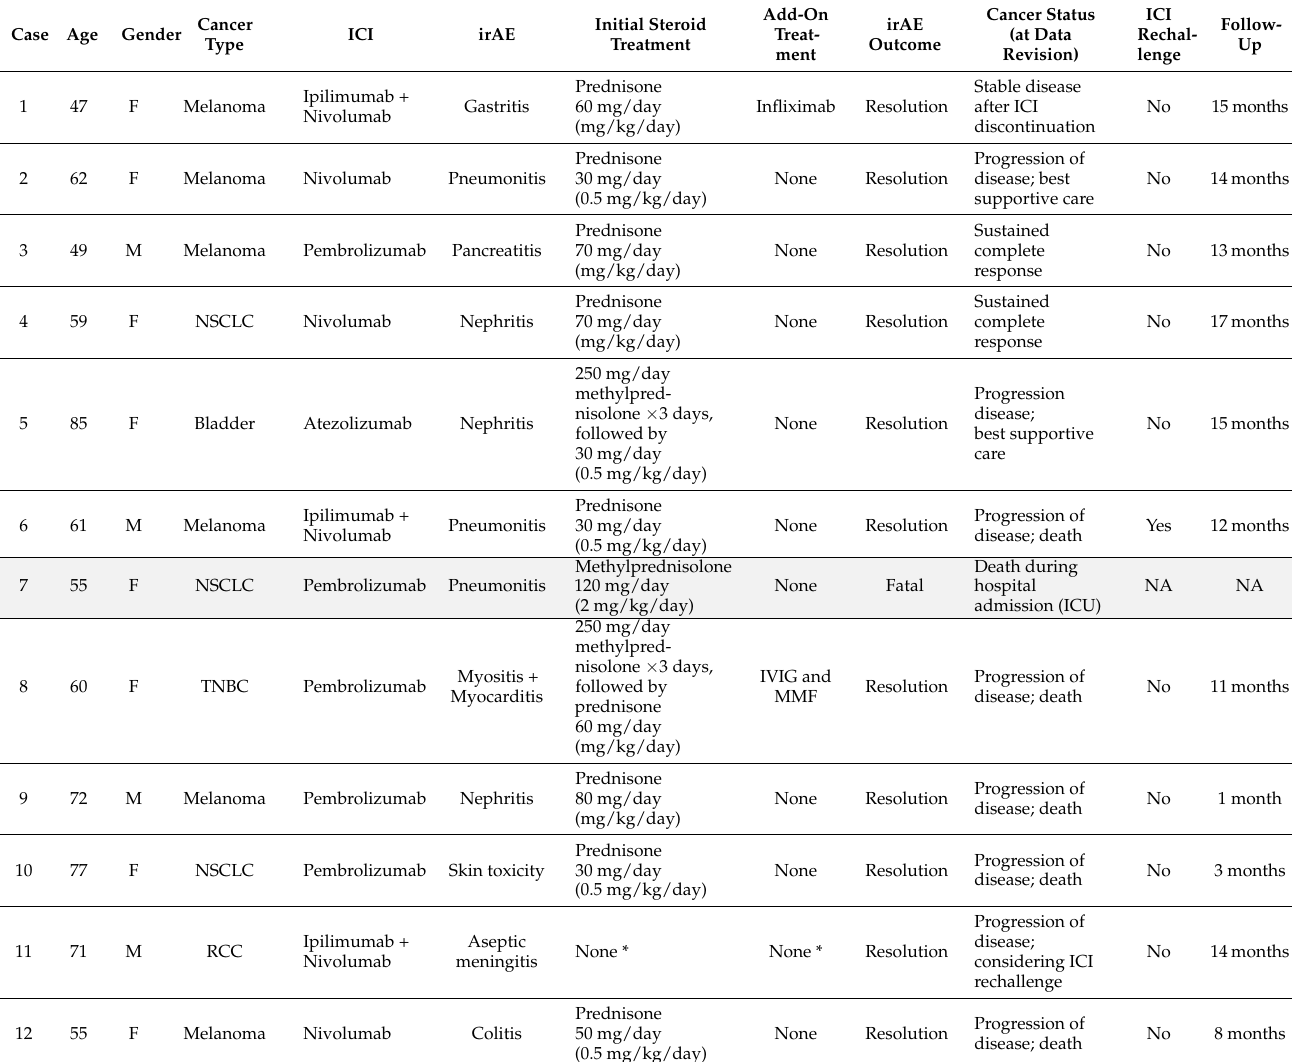
Table 3. Patients’